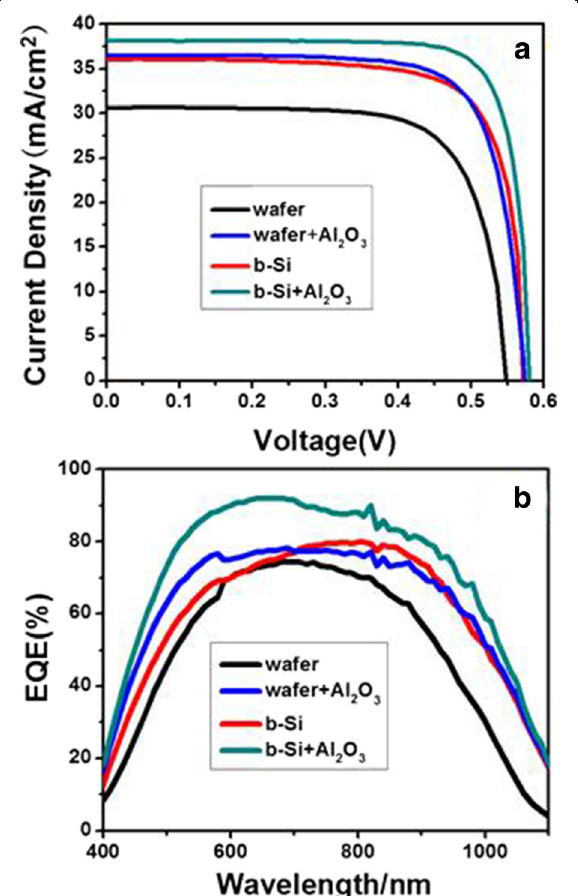
Fig. 4 Photovoltaic J - V ( a ) and EQE curves ( b ) for the solar cells of “ wafer, ” “ wafer + Al ” “ b-Si, ” and “ b-Si+Al ” 2 O 3 , 2 O 3